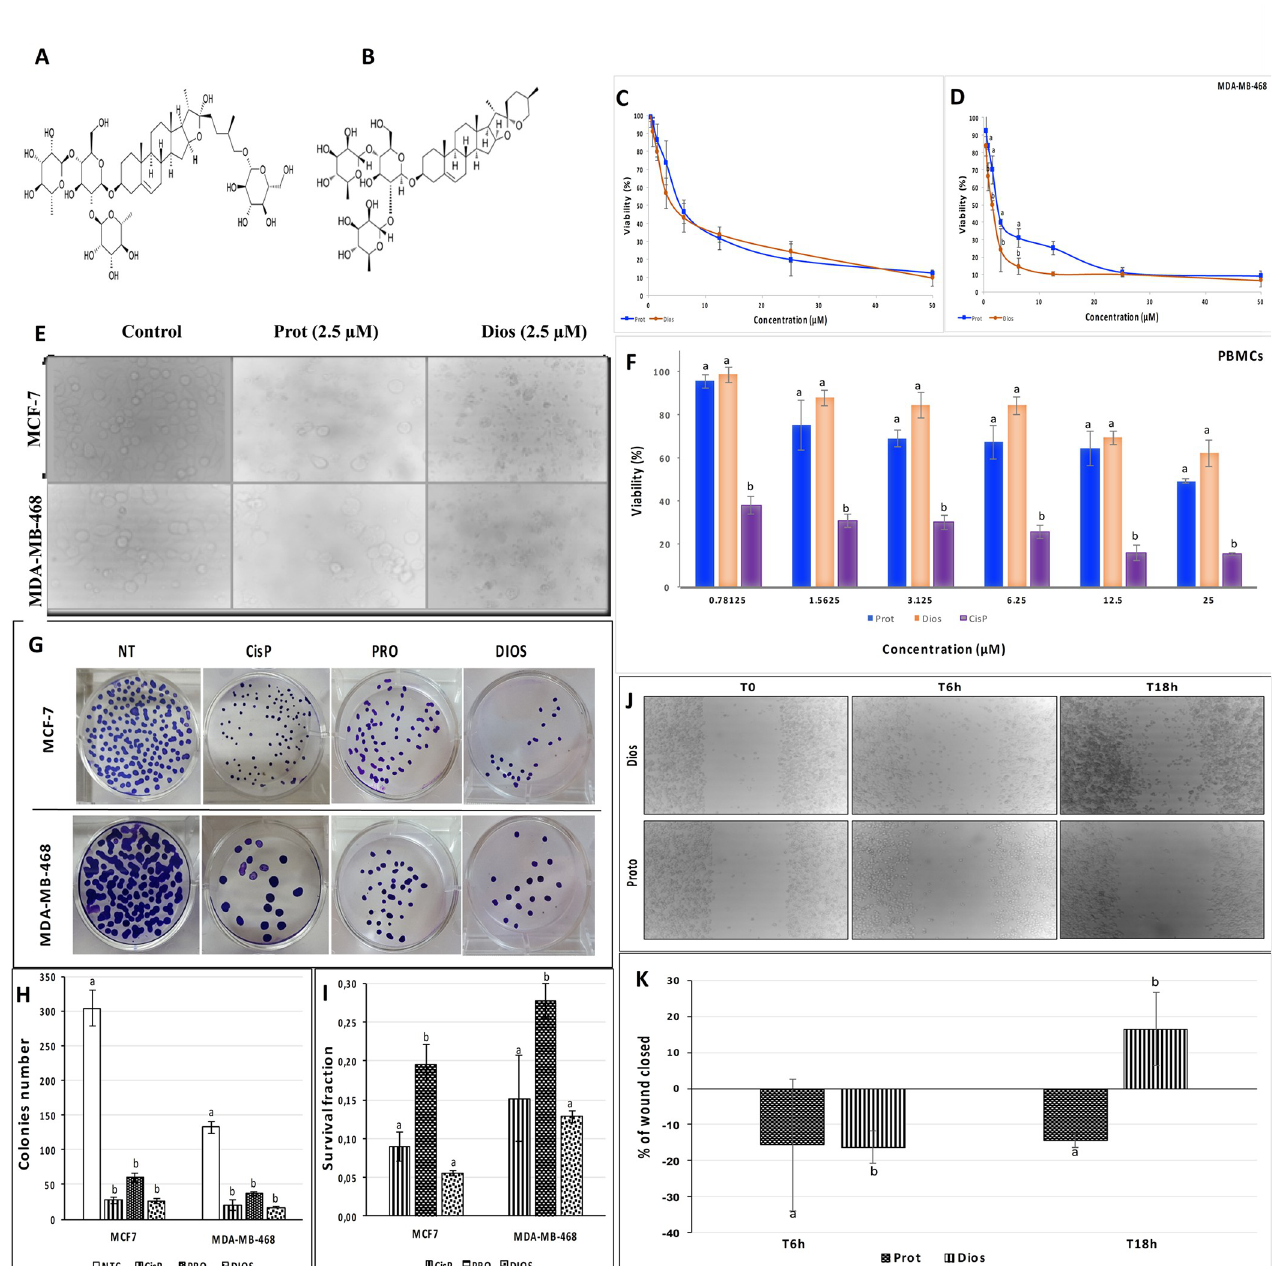
Fig 2. Effect of protodioscin and dioscin on cell growth, clonogenic formation and migration of non-invasive and invasive human breast cancer cell lines (MCF-7 and MDA-MB-468). ( A and B ) In vitro antitumor activity of protodioscin and dioscin towards adenocarcinoma cell line ER+ (MCF-7) and ER- (MDA-MB-468) after 48 hours of treatment. ( C ) In vitro cell proliferation morphological changes were observed after treatment for 48 hours ( × 200, cells all seeded at the same initial density). ( D ) Viability of PBMCs treated with protodioscin or dioscin for 48 hours. ( E , F and G ) ( E ) Sample plate images from the clonogenic assay for cells treated with 1 μ M of protodioscin/dioscin or CisP (0.33 M) for 10 days; ( F ) total number of colonies formed; ( G ) survival fraction. ( H and I ) Migration assay performed on MDA-MB-468 cells treated with 1 μ M of protodioscin/dioscin or CisP (0.33 M) for 6 and 18 hours. Data represented as the mean of three independents measurements. Bars represent the standard error. Different letters indicate significant differences among treatments. P-value < 0.05 indicate significant difference.